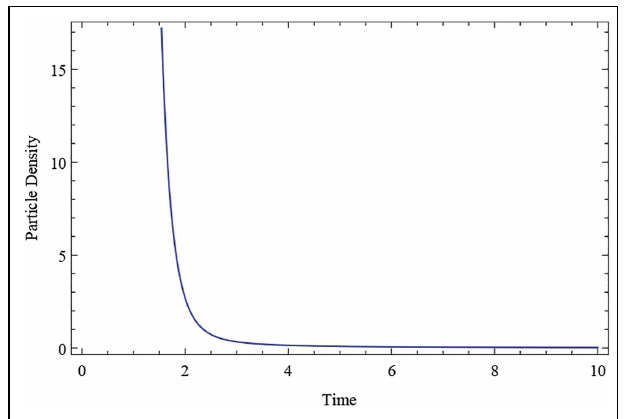
FIGURE 1 | Particle Density ρ p vs. time.